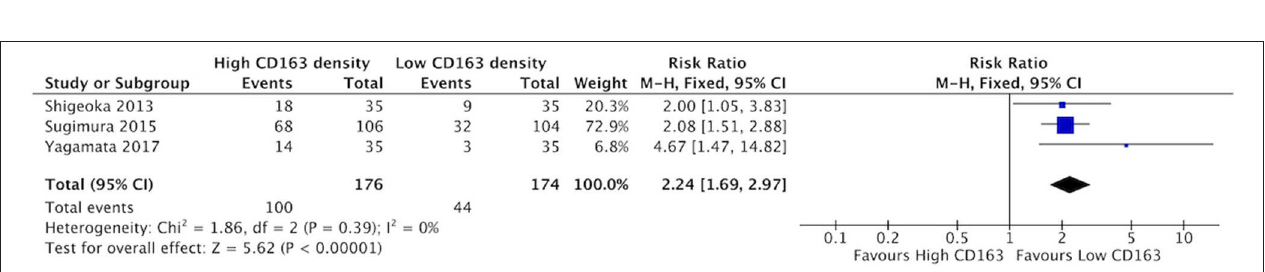
FIGURE 6 | High CD68 + TAM density is associated with higher rates of vascular invasion.